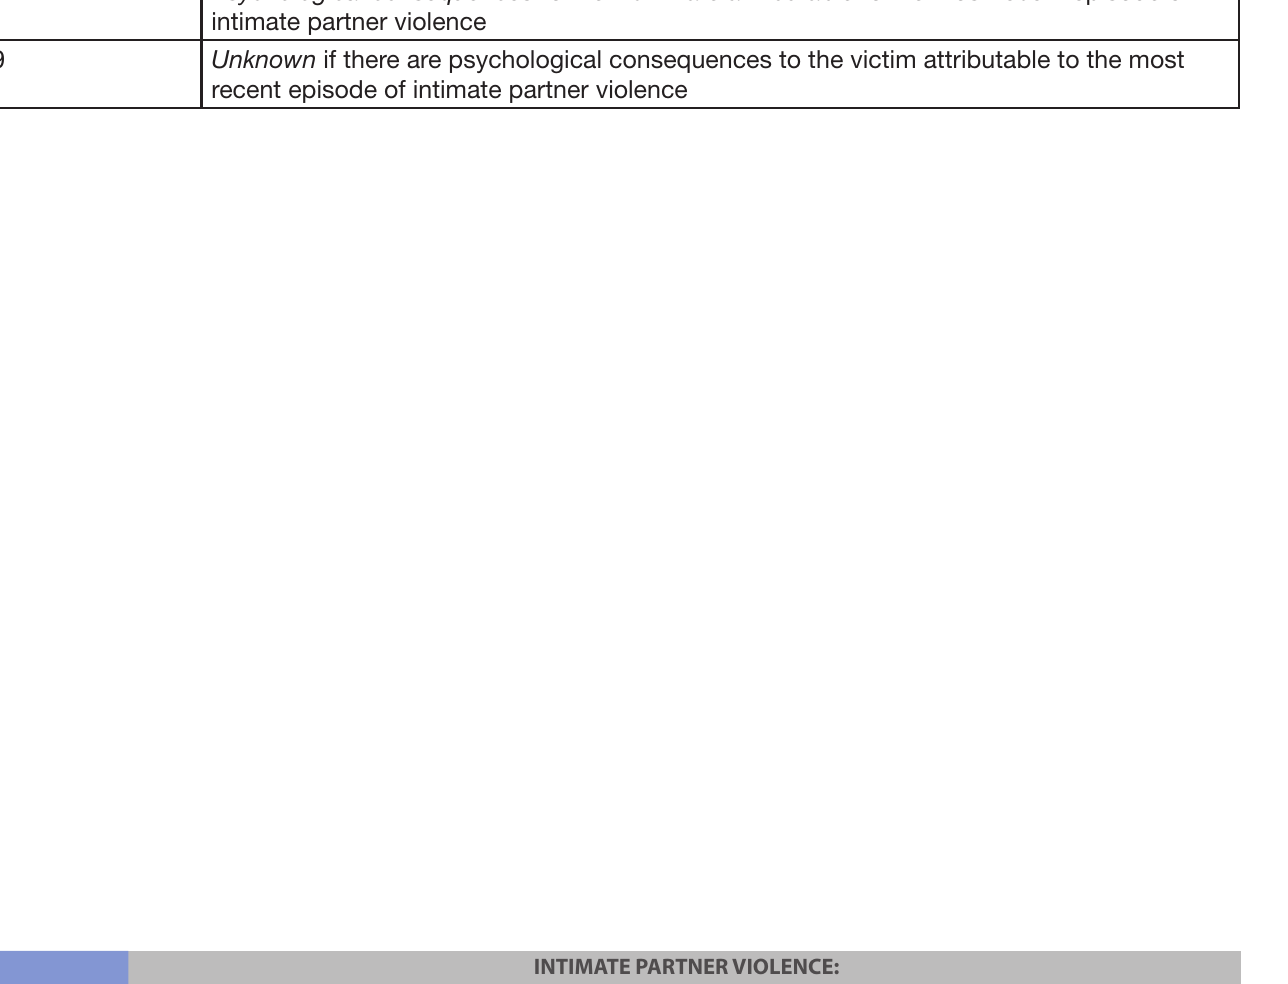
INTIMATE PARTNER VIOLENCE: UNIFORM DEFINITIONS AND RECOMMENDED DATA